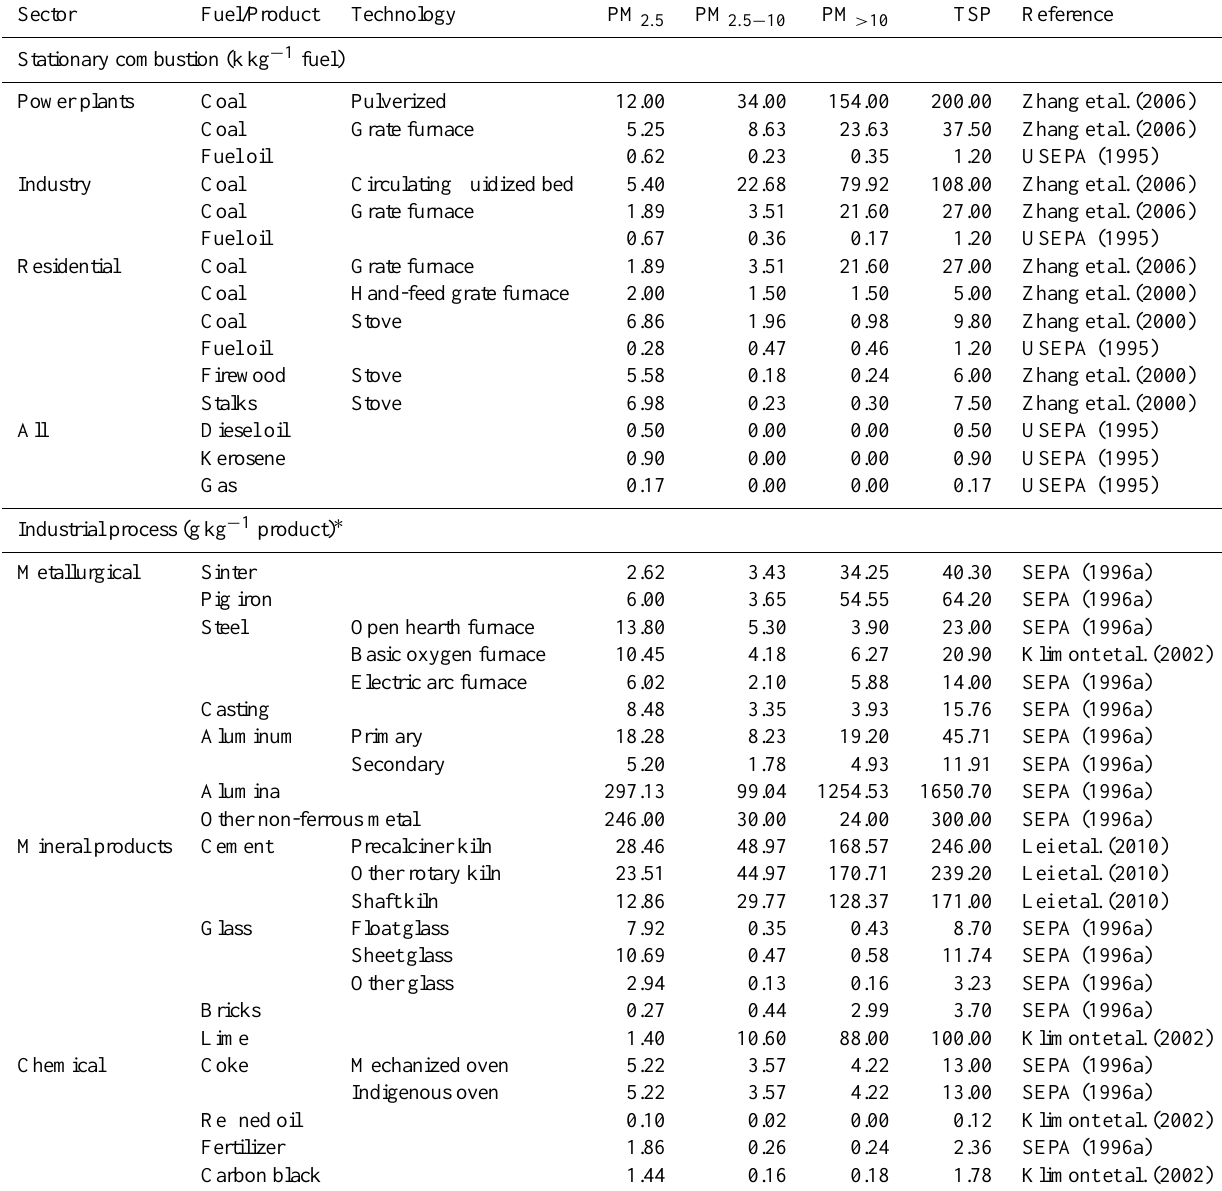
Table 2. Unabated EFs for PM from stationary sources.